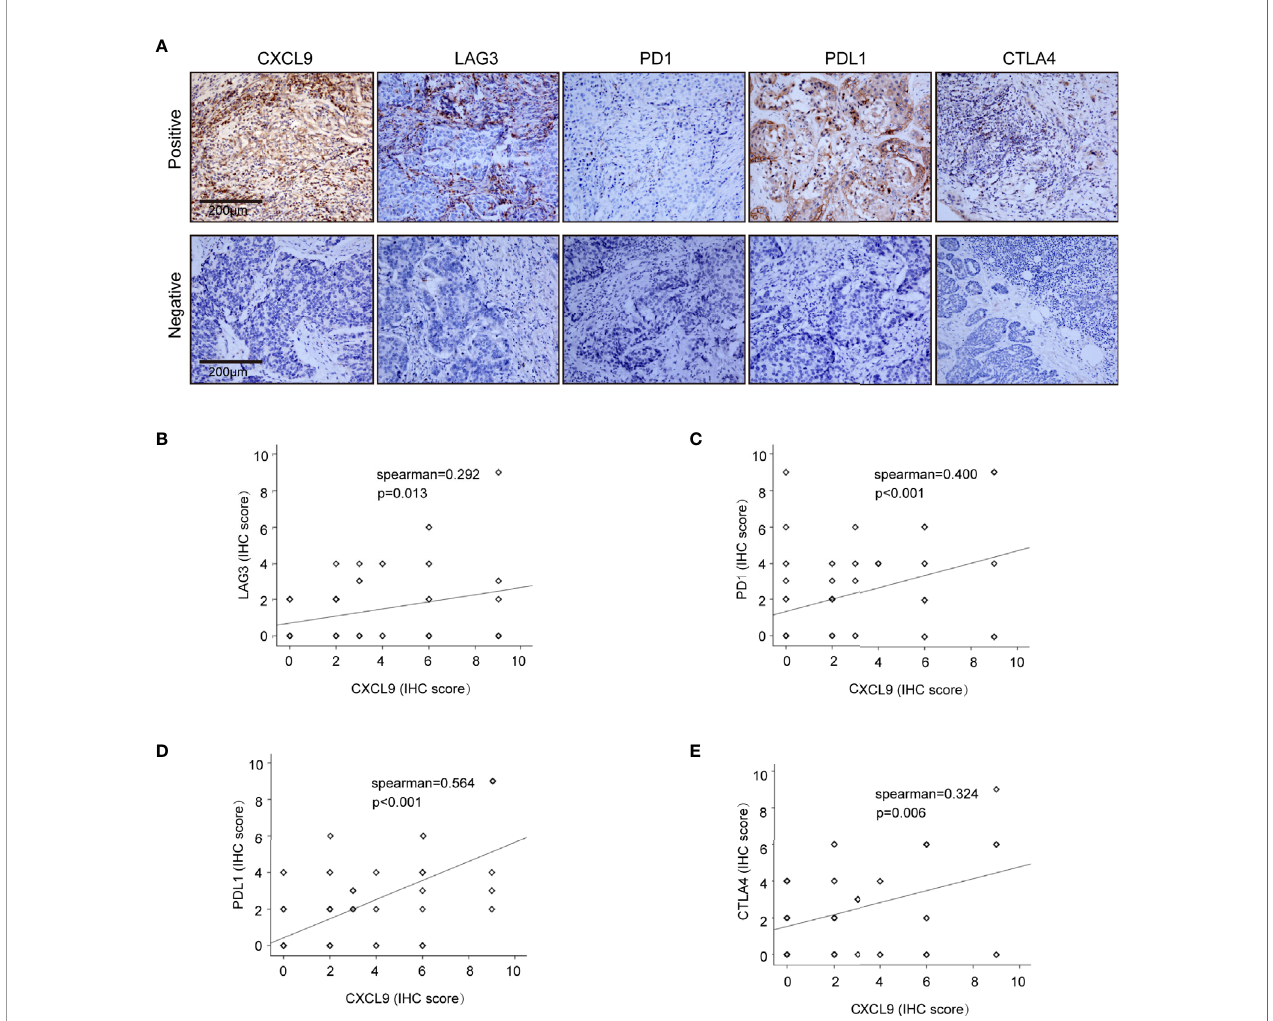
FIGURE 7 | Correlation analysis of CXCL9 expression and immune in fi ltrating biomarkers in BRCA tissues. (A) Immunohistochemical staining for CXCL9, LAG3, PD1, PDL1, CTLA4. (B – E) Correlation analysis between the expression of CXCL9 and potential targets for immunotherapy LAG3, PD1, PDL1,